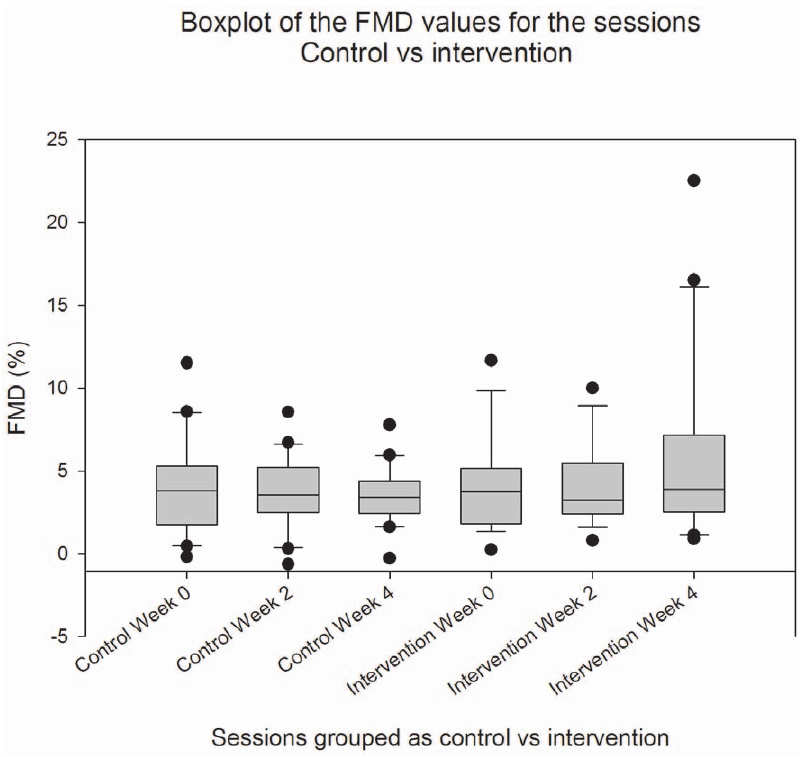
Figure 2. Box plot of the FMD values for weeks 0, 2 and 4 during the study for the Control and Interventional group.